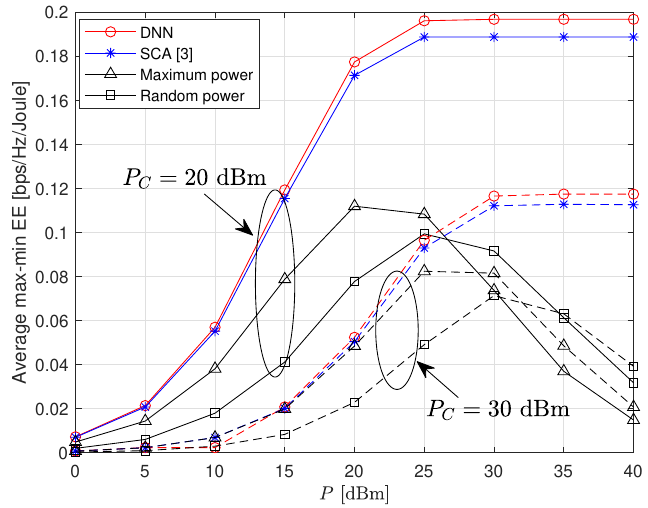
Figure 9. Average max-min EE performance as a function of P with K = 2 for P C = 20 and 30